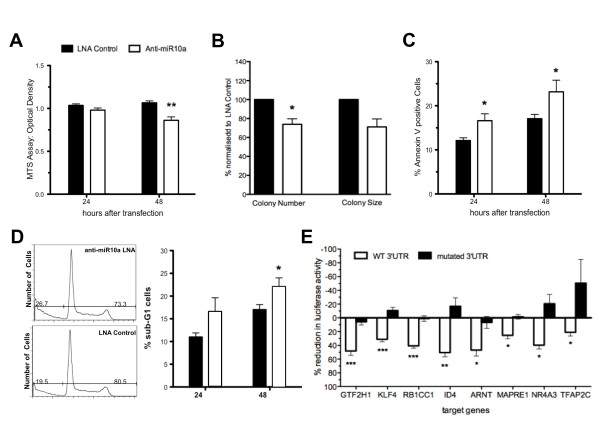
Functional effects of miR-10a. A. Transfection of OCI-AML3 cells with anti-miR10a LNA resulted in 19% reduction in cell count at 48 h as determined by MTS assay. B Assessment of clonogenic potential found a significant decrease in mean colony number (left), and a trend towards reduced Colony Size (right). Values are normalised to Scrambled LNA Control. C A significant increase in the number of Annexin-V positive events at 24 and 48 h. D Cell cycle analysis demonstrated an increase in the proportion of cells in the SubG1 fraction at 24 and 48 h post miR-10a knockdown. Black bars = Scrambled LNA Control, White bars = Anti-miR10a LNA transfected OCI-AML3 cells. E Confirmation of predicted miR-10a gene targets by luciferase reporter assay: ARNT, GTFH1, ID4, KLF4, MAPRE1, NR4A3, RB1CC1 and TFAP2C were confirmed to be miR-10a repressible by this assay. White bars = miR-10a repression of 3'UTR of the gene of interest, Black bars = miR10a repression of mutated miR-10a binding site on the 3'UTR of the gene of interest. All values were subject to normalisation to renilla luciferase activity of a non-specific transfection control. Error bars denote SEM. For all experiments n ≥ 3, statistical significance determined by Two-Tailed T-Test. *p < 0.05, **p < 0.01, *** p < 0.001.